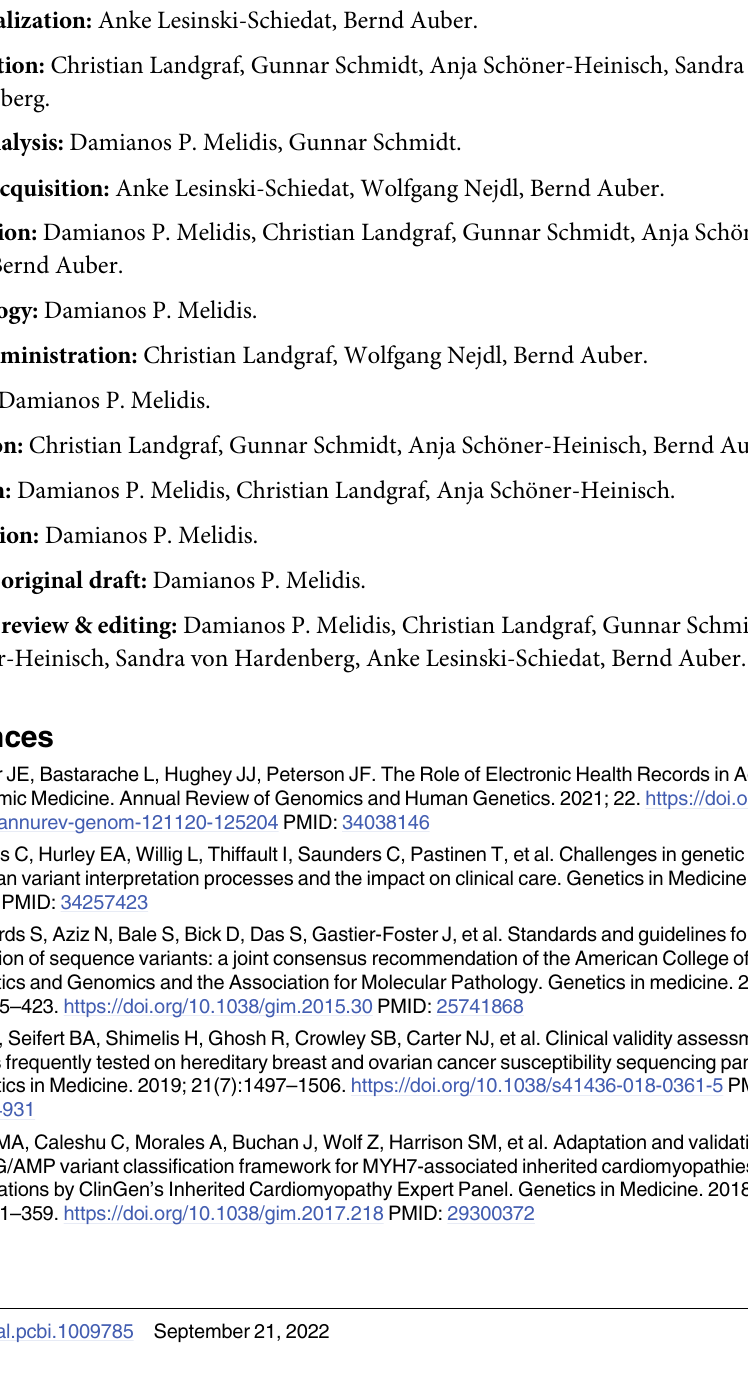
S3 Fig. Conceptual workflow to call clinical significant exons for PVS1 rule.